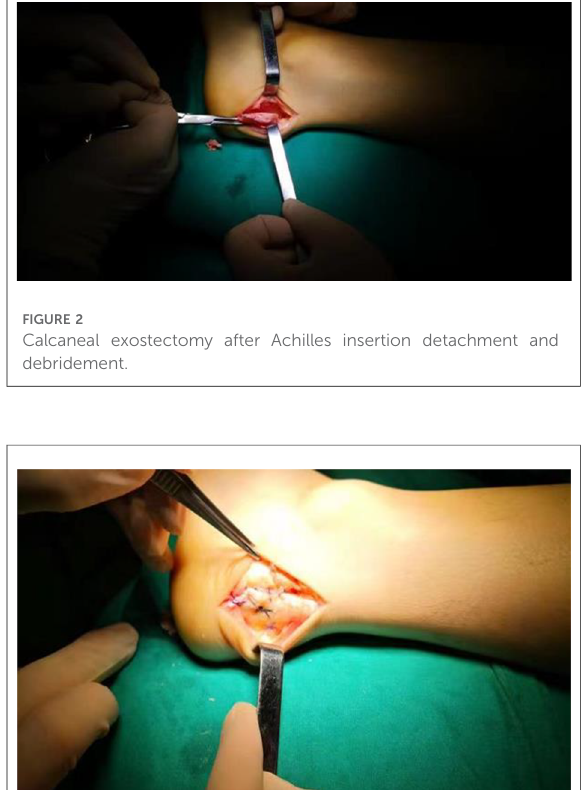
FIGURE 3 Achilles insertion reattachment using a single-row suture anchor technique.